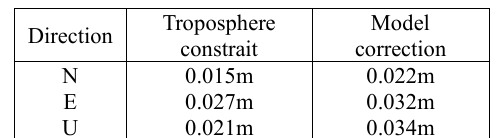
Figure 4. Comparison of PPP convergence speed